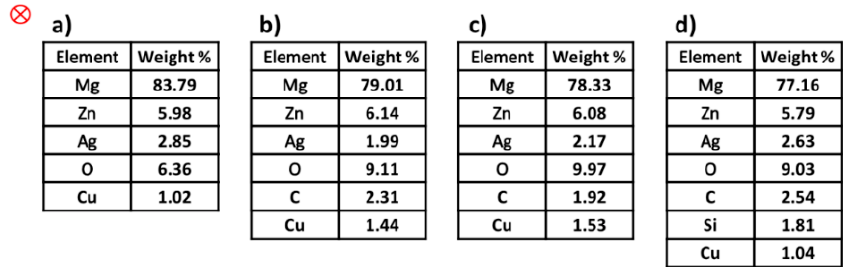
Figure 8. The extracted values of EDAX analysis: ( a ) alloy, ( b ) C1, ( c ) C2 and ( d ) C3.